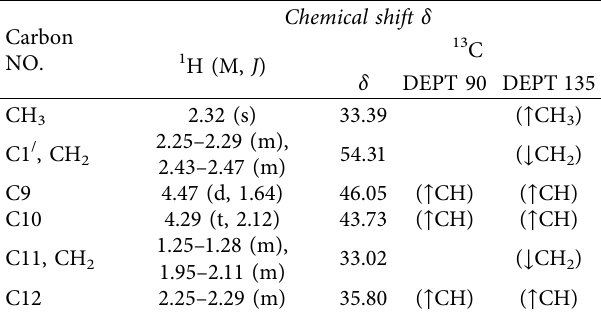
Scheme 1: The retrosynthetic analysis and strategy for compound 1 . Table 1: DEPT and HSQC results of the target amine 1